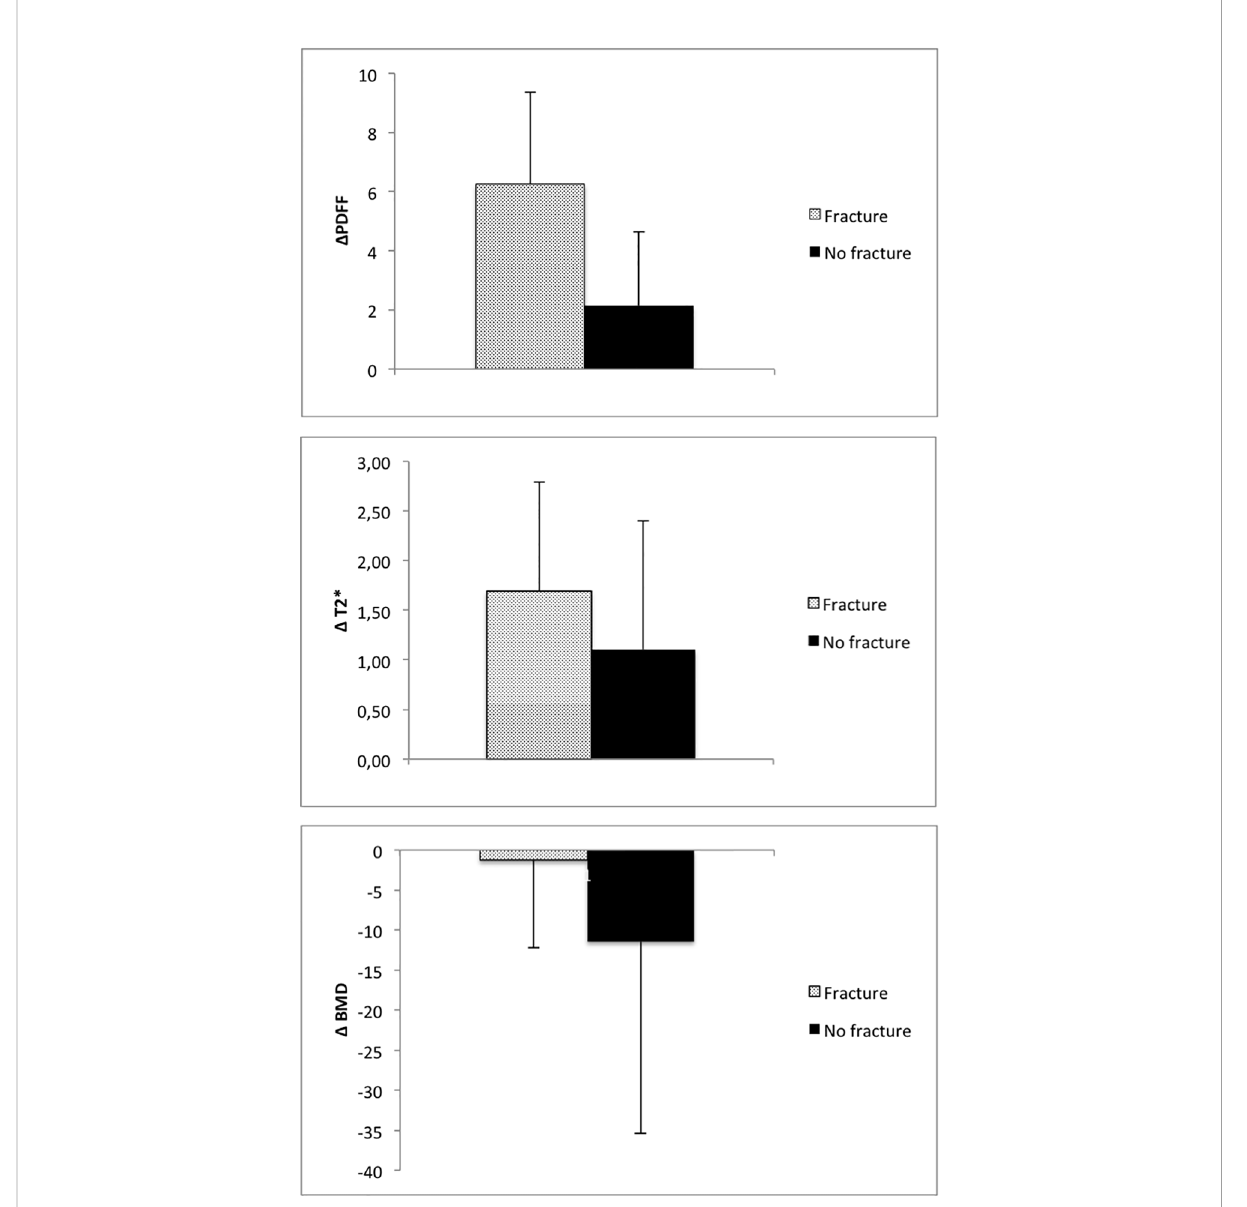
FIGURE 4 Average change of PDFF, T2* and BMD in patients with and without incidental VCF between baseline and 12-month